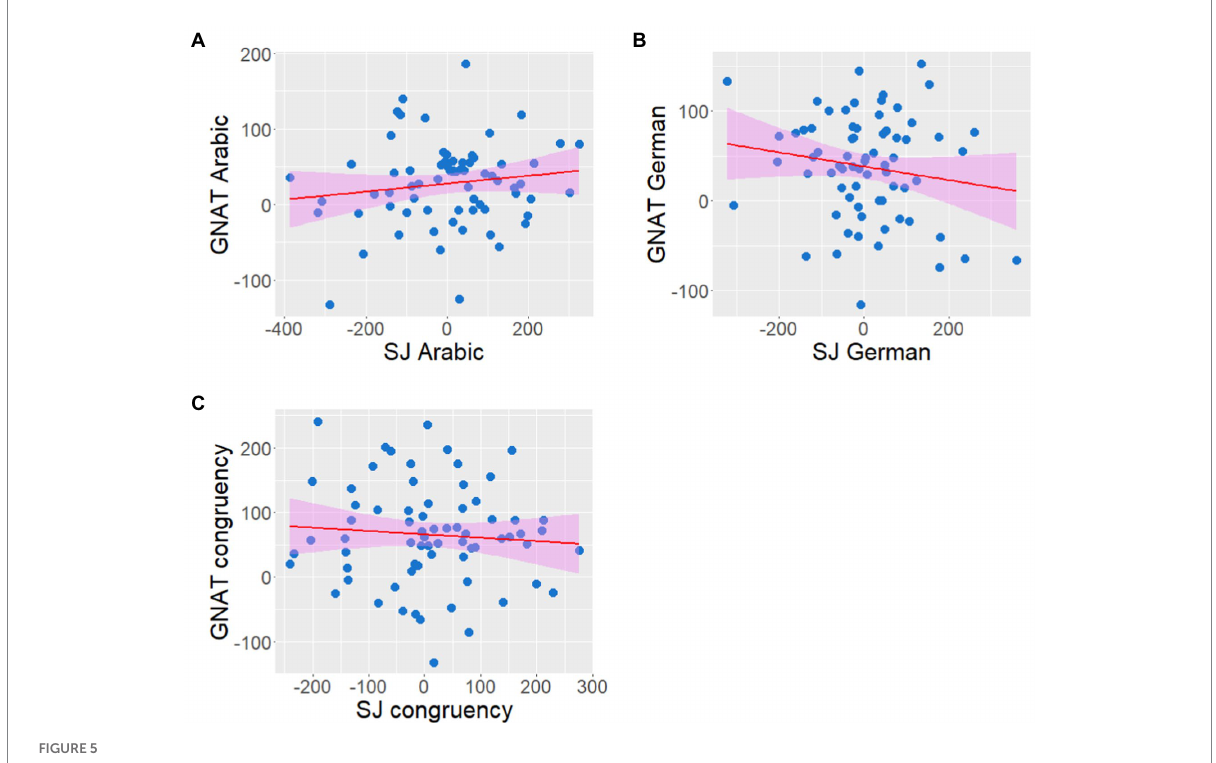
FIGURE 5 Critical pairwise correlations between SJ and GNAT congruency variables. A Correlation between GNAT Arabic stereotypes and SJ Arabic stereotypes . B Correlation between GNAT German stereotypes and SJ German stereotypes . C Correlation between GNAT congruency and SJ congruency . Red lines represent predictions from linear models. Shaded areas represent the 95% confidence intervals. All variables are in milliseconds. No correlation reached significance. See the main text for